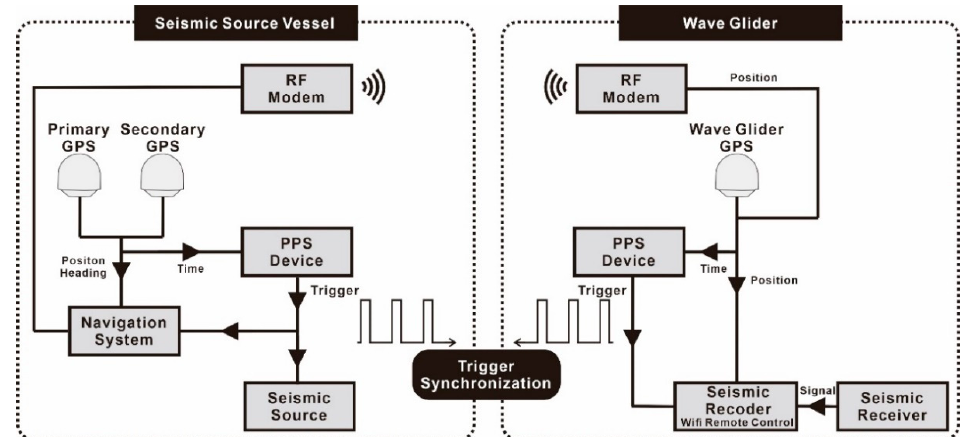
Figure 2. Schematic diagram of the seismic refraction data acquisition system.